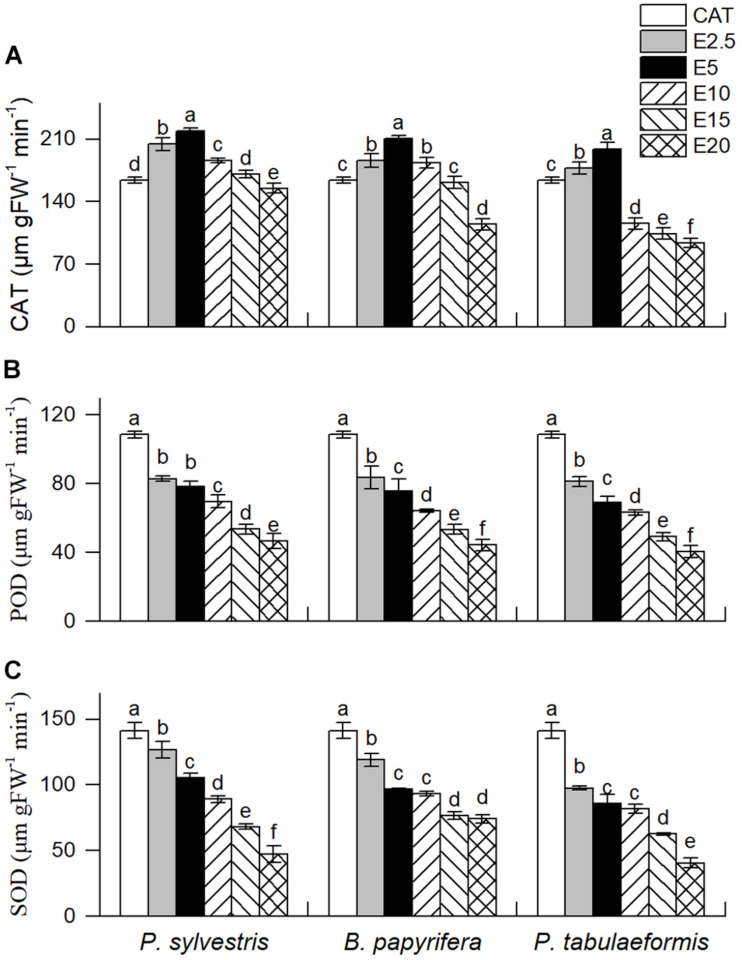
Effect of six different concentrations of aqueous leaf extracts [0% (CK), 2.5% (E2.5), 5% (E5), 10% (E10), 15% (E15), and 20% (E20)] collected from the donor species—P. sylvestris, B. papyrifera, and P. tabulaeformis—on the activities of (A) catalase (CAT), (B) peroxidase (POD), and (C) superoxide dismutase (SOD) of YC-1. Different letters in the same column indicate significant differences among different concentrations of aqueous leaf extracts from the same tree at the 0.05 level. Vertical bars represent standard deviation (n = 4).